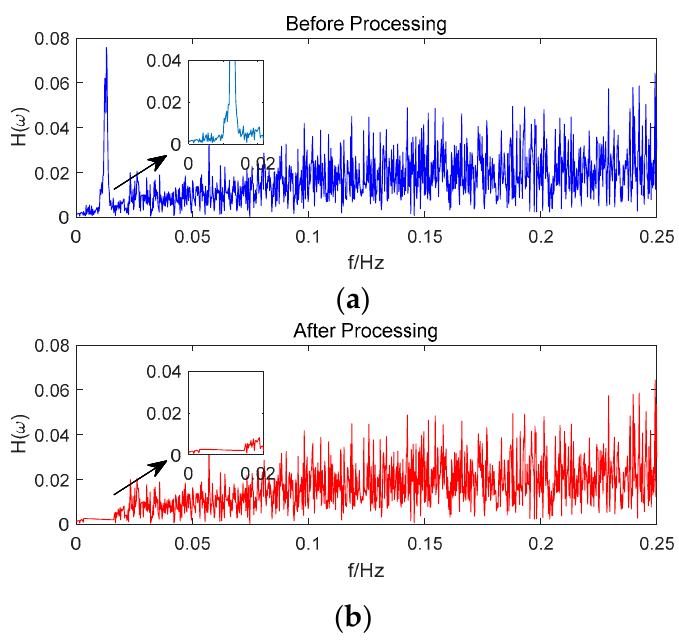
Figure 19. ( a ) Frequency spectrum before smoothing with the spectrum peaks extracting method and CMCD correction model, R20, ( b ) Frequency spectrum after smoothing with the spectrum peaks extracting method and CMCD correction model, R20.